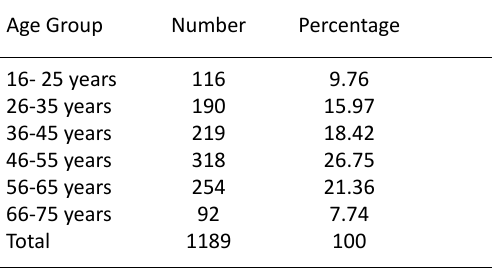
Table 1. Age wise distribution of cases